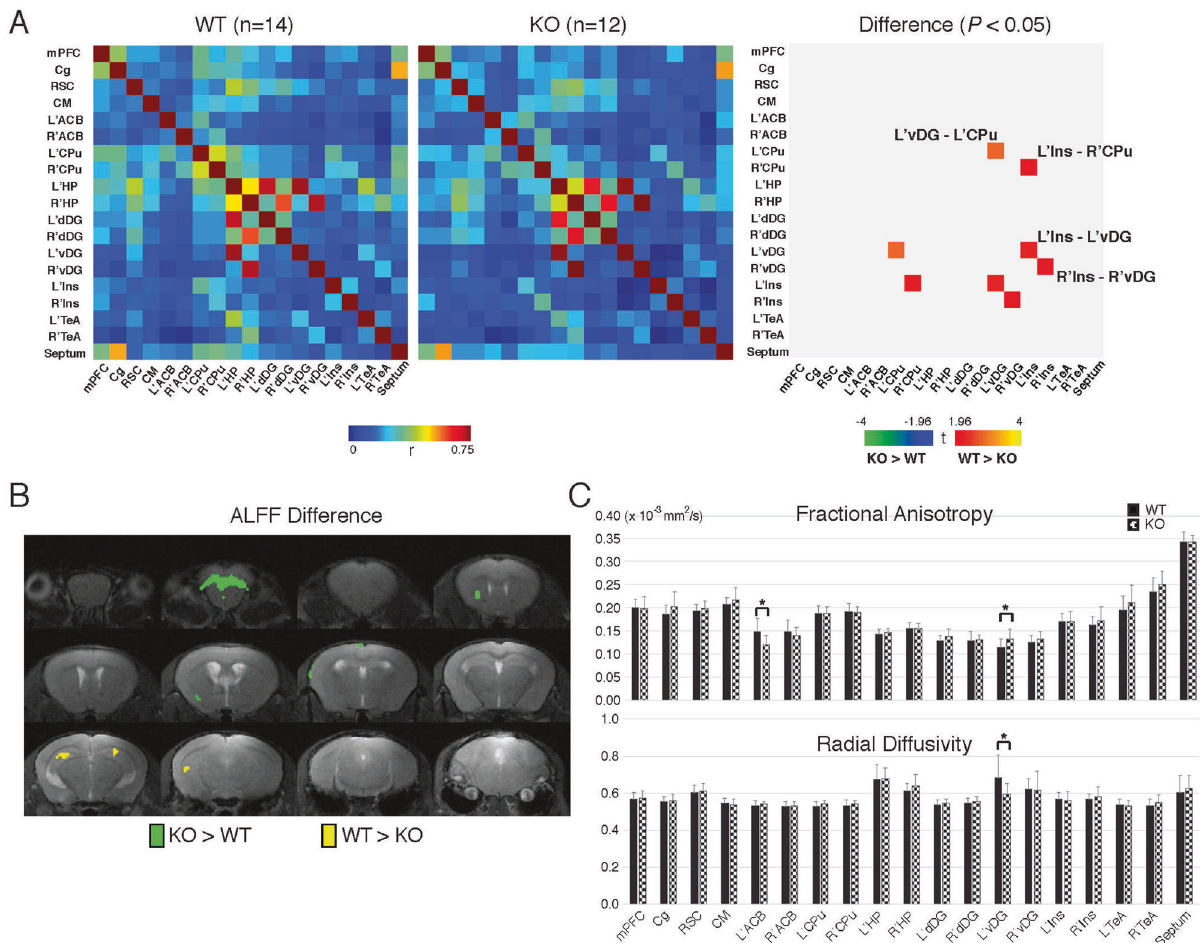
Fig. 3 Reduced ventral DG-caudate nucleus/putmen and ventral DG-insula connectivity in Blm-s − / − mice. A State brain connectivity was accessed by calculating the correlation matrix among 11 ROIs. The MRI images were preprocessed via AFNI toolbox and the signal time course in each ROI was obtained, where the 11 signal time courses were then compared to each other to generate the correlation matrix in each mouse. ACB nucleus accumbens, Cg cingulate gyrus, CM central medial thalamic nucleus, CPu caudate nucleus/putmen, dDG dorsal DG, vDG ventral DG, HP hippocampus, Ins insular cortex, mPFC medial prefrontal cortex, RSC retrosplenial cortex, TeA temporal association cortex (see Supplementary Fig. S5A for graphic illustration of ROI). n = 12 Blm-s − / − (KO) and 14 WT mice, Two-sample t -test ( P < 0.05 as signi fi cant). B State activities were evaluated and compared by calculating the amplitude of low-frequency fl uctuations (ALFF) in a voxel-wise manner. Higher activity of ALFF was shown in the hippocampus of KO mice. C The DTI parameter comparison in various brain ROIs of KO and age-matched WT mice is shown by bar graph, indicating altered fractional anisotropy (FA) and axial diffusivity (AD) in the hippocampus of KO mice. n = 12 KO and 14 WT mice, * P < 0.005, Two-sample t